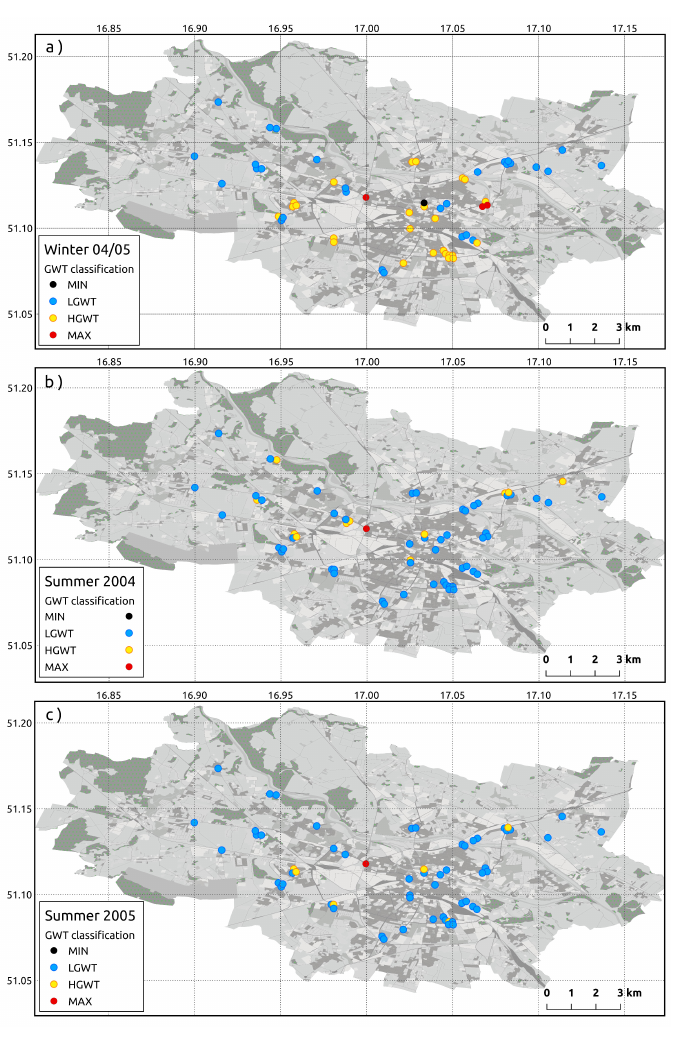
Figure 4. Spatial visualization of GWT anomalies in: ( a ) winter 2004/2005, ( b ) summer 2004 and ( c ) summer 2005. Map projection EPSG:4326.